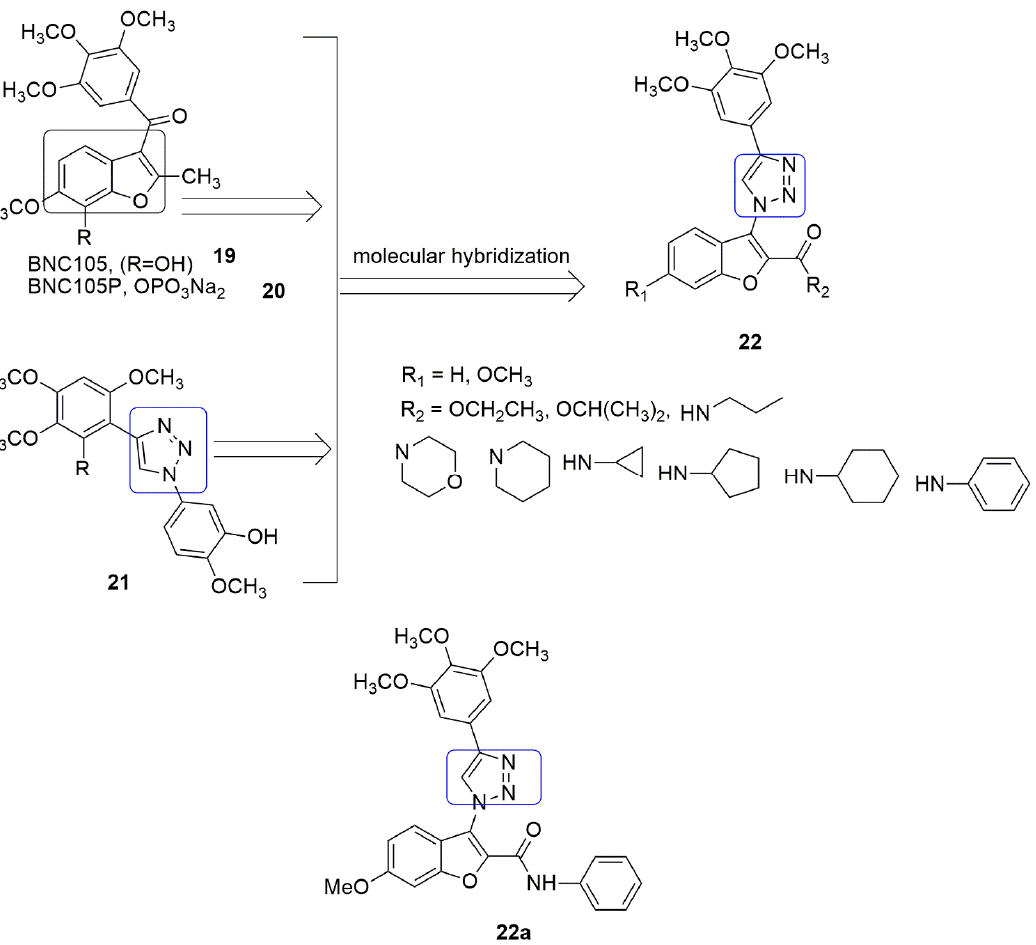
Figure 9. Chemical structures of benzo[ b ]furan and triazole moieties that displayed antiproliferative and anti-tubulin ac- tivity. A novel series of tubulin inhibitors bearing an indole-1,2,4-triazole ( 25 ) scaffold have been synthesized, and their biological activity has been reported[31]. Among the 18 com- pounds evaluated for anti-proliferation activity against HepG2 (human hepatoma cells), HeLa (human cervix cell), MCF-7 (breast cancer cell), and A549 (human lung cancer cell), compound 25a displayed excellent activity with IC 50 values of 0.23±0.08, 0.15±0.18, 0.38±0.12, and 0.30±0.13 µM, respectively. The substitution of electron-donating groups such as OCH 3 and CH 3 ( 25a-d ) enhanced the anti-proliferative activity compared to the electron-withdrawing groups (F, Cl, Br, I, and CF 3 ). The results from the tubulin polymer- ization assay showed that compound 25a was the most potent anti-tubulin agent ( IC 50 = 2.1± 0.12 µM), superior to the inhibitory activity of colchicine (2.52 ± 0.23 µM). Moreover, 25b-d inhibited tubulin polymerization with IC 50 values of 5.08 ± 0.16, 3.4 ± 0.43, and 6.92 ± 0.21 µM respectively. 25a induced cell cycle arrest at the G2/M phase associated with a reduction in mitotic cells and induced downregulation of the anti-apoptotic proteins Bcl- 2, Bcl-x1, and mainly Mcl-1, an essential component for cell survival. Molecular docking revealed that compound 25a interacts with tubulin at the colchicine binding site (see Fig- ure 10).